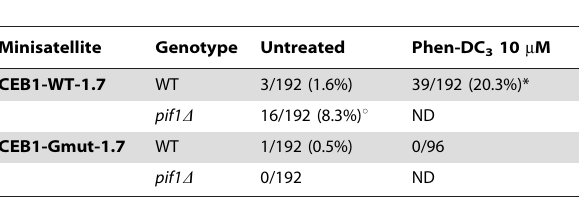
Table 2. Internal rearrangement frequencies of CEB1 in WT cells treated or not with 10 m M Phen-DC 3 , and in pif1 D